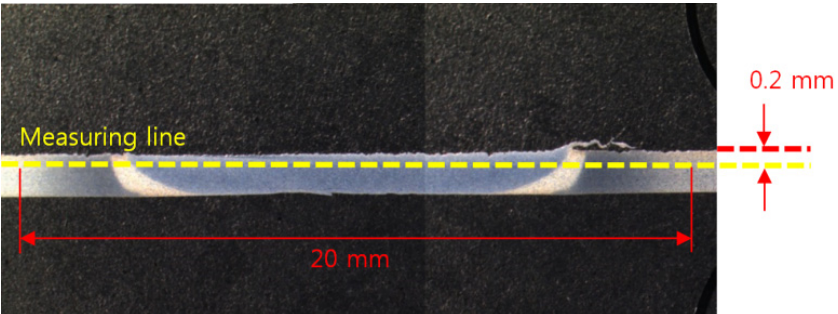
Figure 2. Schemes of hardness measurement positions.